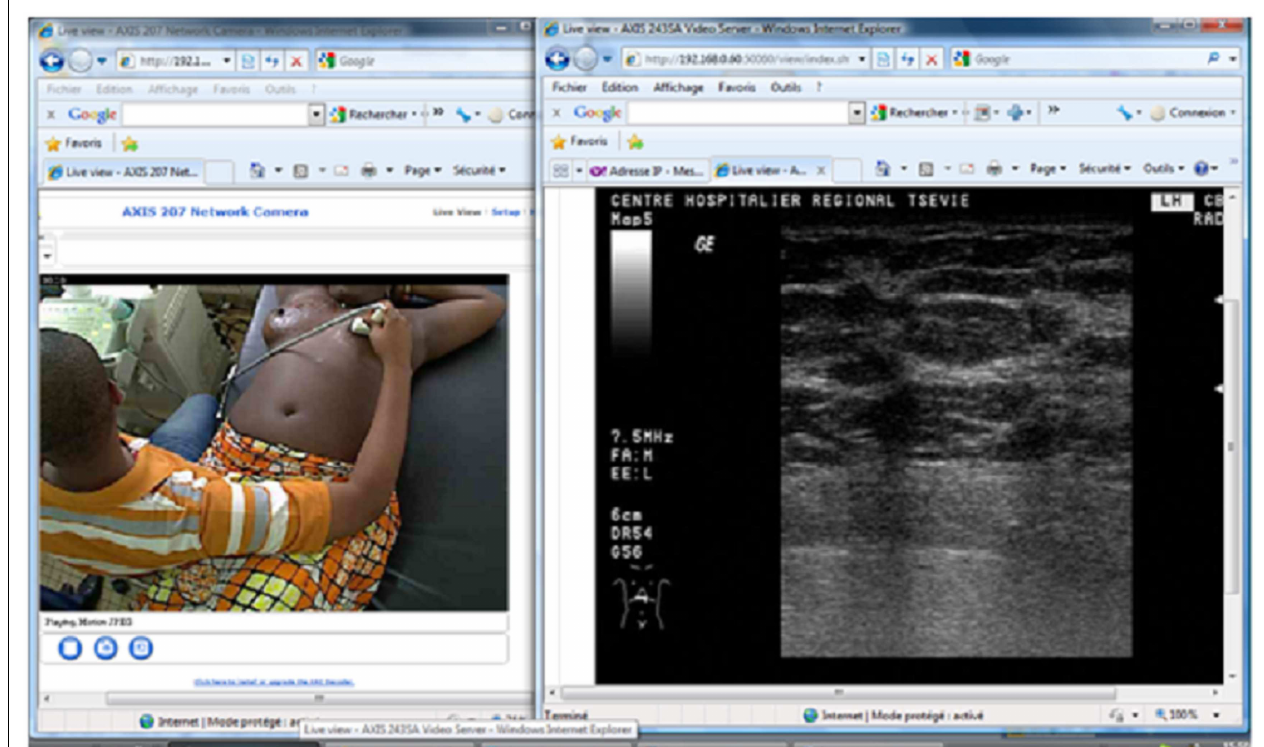
FIGURE 1 | Screen capture at the expert center during mammary ultrasound withAxis technology